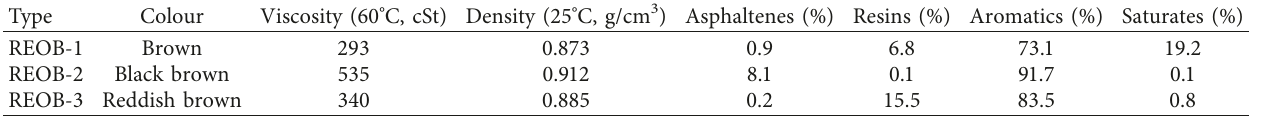
Table 1: Basic properties and chemical components of three types of REOB.